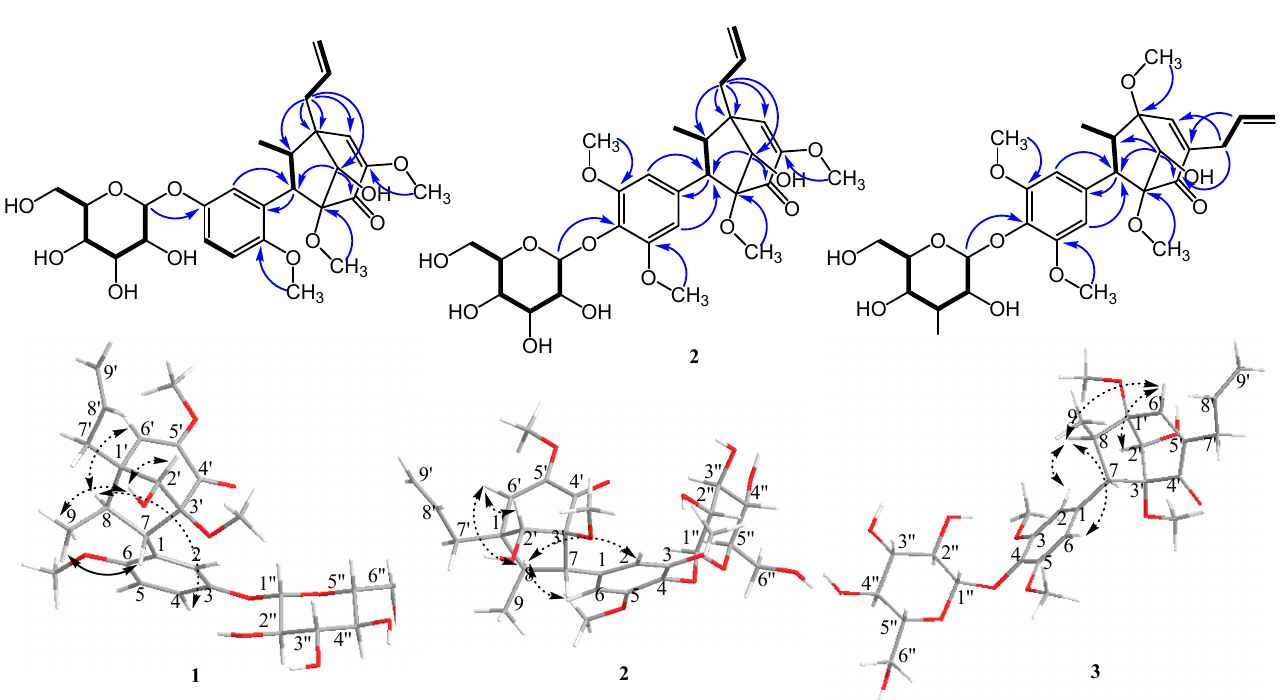
Figure 2. Key COSY (bold lines), HMBC (H → C), and ROESY (dashed arrows) correlations for new compounds ( 1 – 3 ). The relative stereochemistry of methyl (H-9) and aryl groups was revealed from the key ROESY correlation between H-9 and H-7, and no correlation was observed between H-9 and aromatic ortho-protons (H-2 and H-6). However, a correlation between H-8 and H-4 was observed. Therefore, the trans-relationship of methyl (H-9) and aryl groups was confirmed [4]. Additionally, the correlations between H-2 (cid:48) , –OH-2 (cid:48) , and H-9 were observed, which indicated the endo conformation of the hydroxy group on C-2 (cid:48) . The correlation between H-9 and –OH-2 (cid:48) , which indicated the relative configuration of the hydroxy group, suggested endo configuration with the methyl (H-9) group. The relative configuration of 1 was further determined based on the reported chemical shifts of H-7, H-6 (cid:48) , and